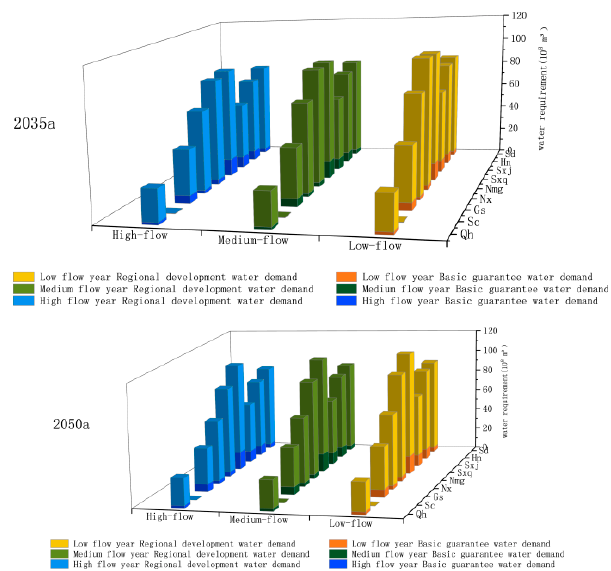
Figure 7. Forecast of water demand of each province in 2035a and 2050a.